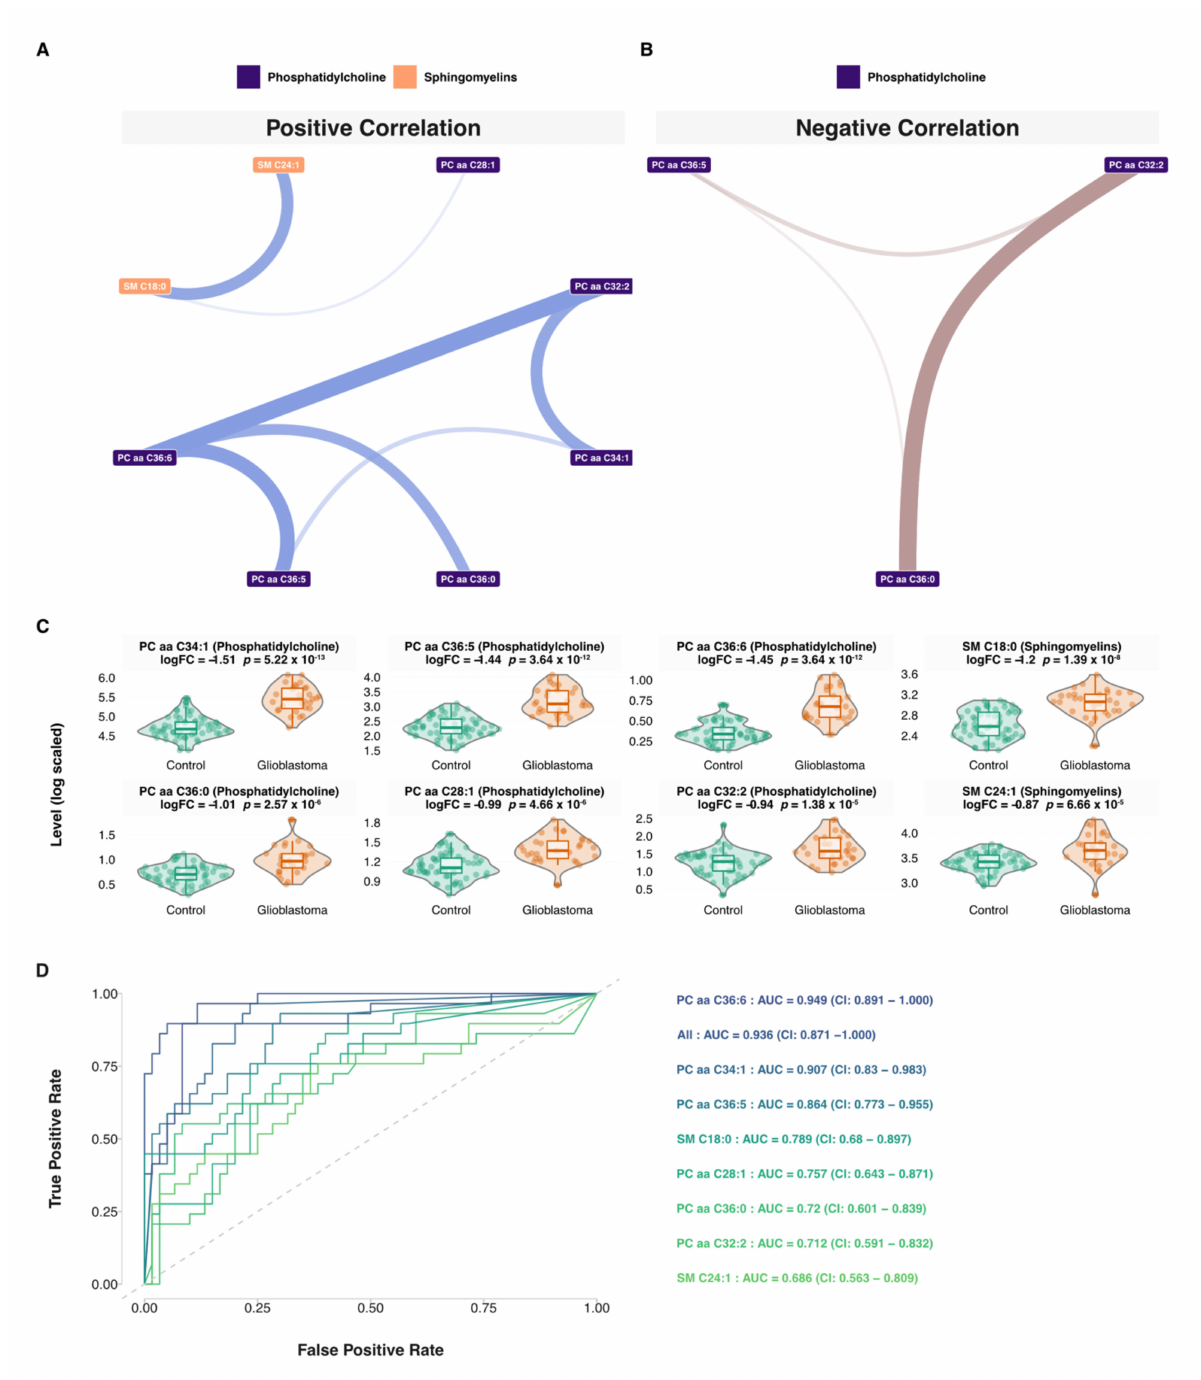
Figure 7. Network and machine learning analysis. ( A ) Negative correlation network visualization of the glioblastoma consensus metabolic signature. ( B ) Positive correlation network visualization of the glioblastoma consensus metabolic signature. Line width is proportional to the Spearman correlation. ( C ) Boxplots of the consensus plasma metabolic signature. ( D ) ROC curves of the Random Forest predictive models, including seven phosphatidylcholines (PC aa C36:6, PC aa C32:2, PC aa C36:0, PC aa C36:5, PC aa C34:1, and PC aa C28:1) and two sphingomyelins (SM C18:0 and SM C24:1). AUC and 95% confidence intervals (CI) were calculated using balanced subsampling with 50